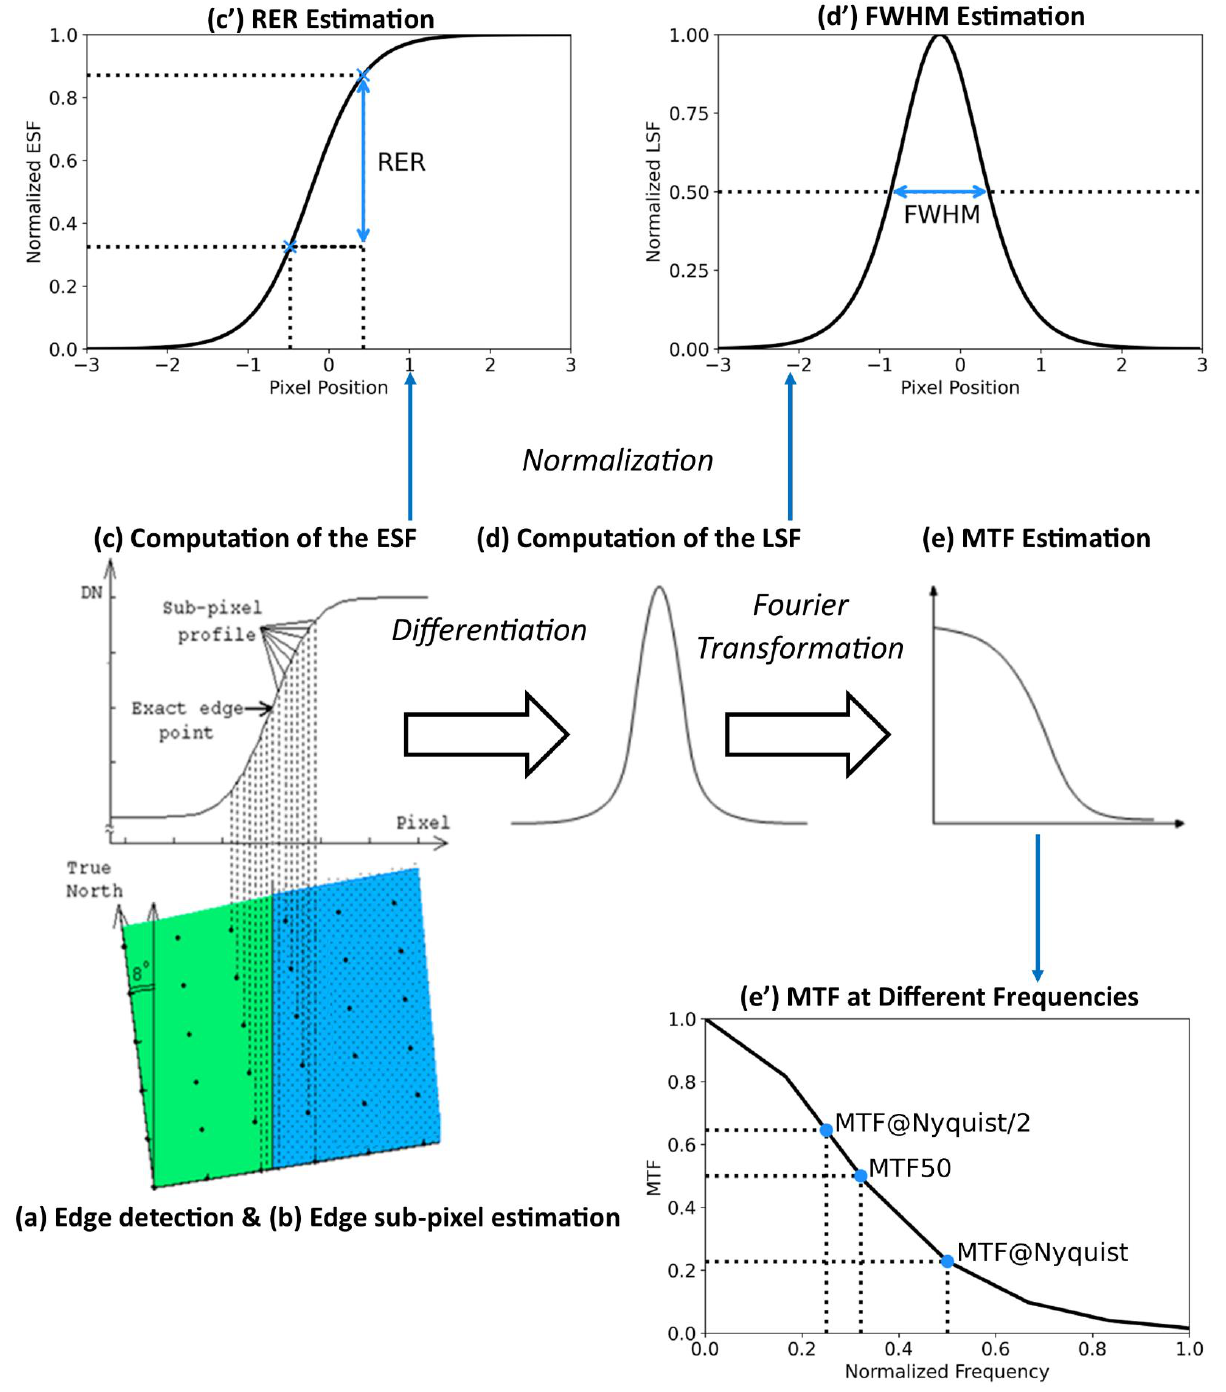
Figure 1. Schematic representation of the EM that from an edge target imaged by a sensor ( a ) allows first to estimate the its position with a sub-pixel precision ( b ), then to retrieve the corresponding ESF ( c ), LSF ( d ) and MTF ( e ); from which different sharpness metrics can be derived: the RER ( c ′), the FWHM ( d ′), and the MTF computed at different sampling frequencies ( e’ ). Sources: panels ( a – c ) adapted from [17]; panels ( d , e ) adapted from [14].